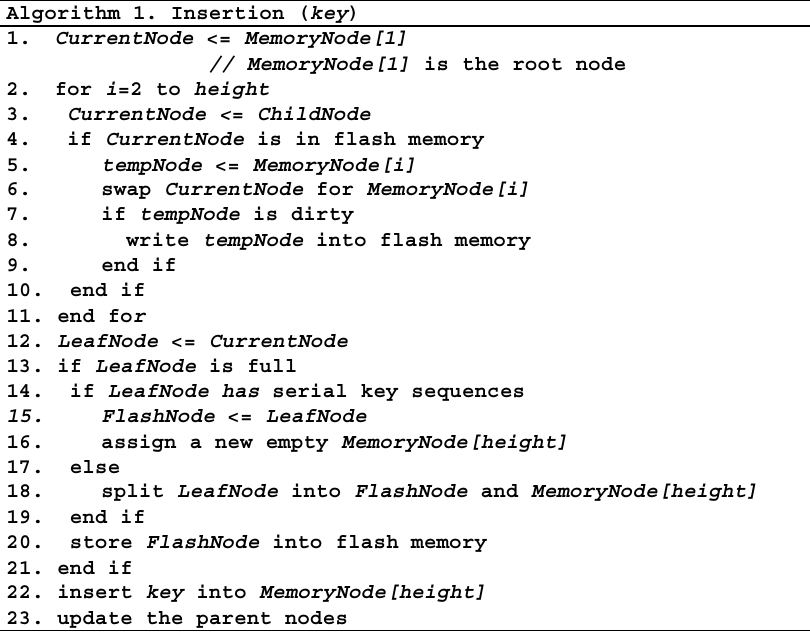
Figure 9. Example of the insert operation in the case of sequential insertions. The benefit in two aspects can be gained from direct flushing the leaf node without node splits. In terms of performance, the number of write operations on the flash memory decreases. Most files and records are sequentially written in the general file systems and the conventional database system [46]. If a large amount of records with sequential key values are inserted, our approach has more performance gains. Since the leaf memory node is almost empty after flushing the leaf node in the case of sequential insertions, large sequential insertions are performed in the leaf memory node without node splits and node switching. Consequently, the write performance increases because many write operations are deferred on flash memory. In terms of page usage, the page utilization of the leaf node increases because the entire space of the flash page is fully filled with records of the leaf node, whereas only half of the flash page is filled if splitting the leaf node. 3.4. Delete Operation The delete operation in CB-tree is similar to the insert operation. All record deletions are performed in the memory node. First, CB-tree finds a target leaf node to delete a record by visiting the nodes from the root node to the leaf node. If there are flash nodes in visited nodes, CB-tree performs node switching. After swapping the nodes, the record deletion is performed in the leaf memory node and parent nodes are then also updated with the information of the changed leaf node. When the leaf memory node underflows after the record deletion, the leaf memory nodes retain its status in order to delay the write operation on the flash memory. That is, the underflowed leaf node will not be merged with its neighbor leaf node before node switching is performed. Similar to the B- tree, the underflow node is merged with its neighbor node after node switching. As shown in the top of Figure 10, for example, when a record with key 25 is deleted, the record with key 25 in leaf node D’ is removed without any flash operation because the deleting record stays in the memory node. After the deletion, if records with keys 20 and 21 are deleted, leaf node D’ will underflow. Since leaf node D’ is the memory node, CB-tree does not perform the merge operation for